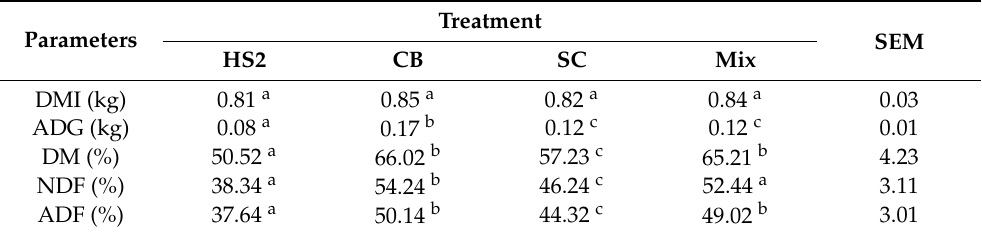
Table 5. The growth performance parameters of the heat-stressed goats supplemented with Clostrid- ium butyricum and Saccharomyces cerevisiae